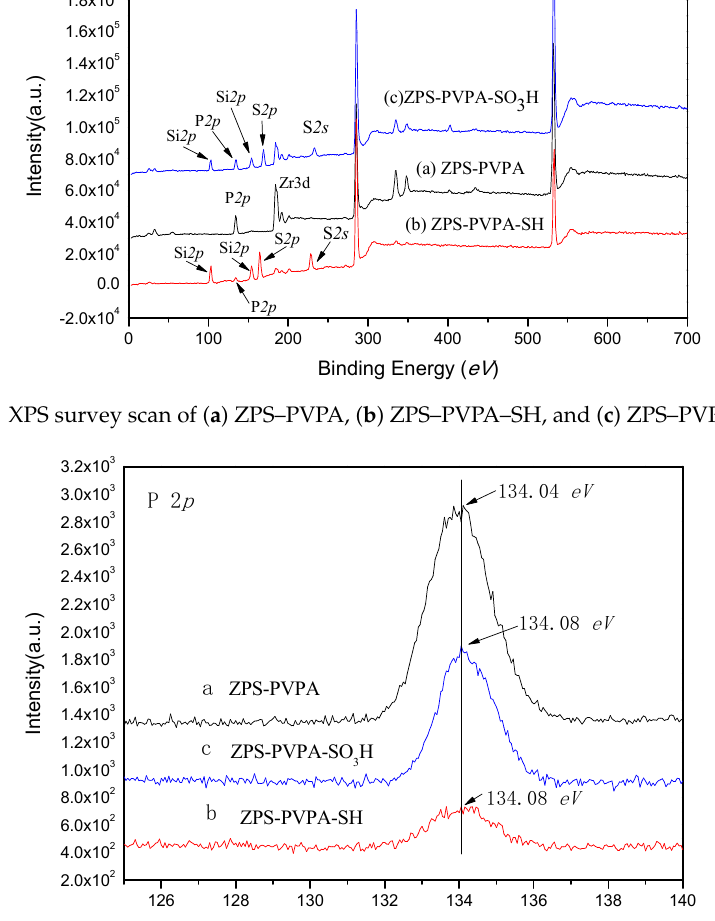
Figure 3. XPS of S 2p3/2 peaks of ( a ) ZPS–PVPA–SH and ( b ) ZPS–PVPA–SO 3 H. 2.3. XRD Analysis Figure 4 presents the XRD patterns of ZPS–PVPA, ZPS–PVPA–SH, and ZPS–PVPA–SO 3 H. It can be seen from the XRD spectrum that there has no obvious peak, indicating that the surface morphologies of the ZPS–PVPA, ZPS–PVPA–SH, and ZPS–PVPA–SO 3 H are amorphous. The broad peak at 2 θ = 15.0 − 30° is mainly attributed to the amorphous silica. Furthermore, the fine diffraction peaks in ZPS–PVPA, ZPS–PVPA–SH and ZPS–PVPA–SO 3 H are attributed to the special structure of the organic–inorganic hybrid zirconium phosphate. Theoretically, each of the composite zirconium salt particles is composed of a plurality of layered composite zirconium salt crystallites, and the arrangement of the crystal planes of the respective zirconium salt crystal grains is random. Therefore, the results are very likely to present a form of “short-range order, long-range disorder”.